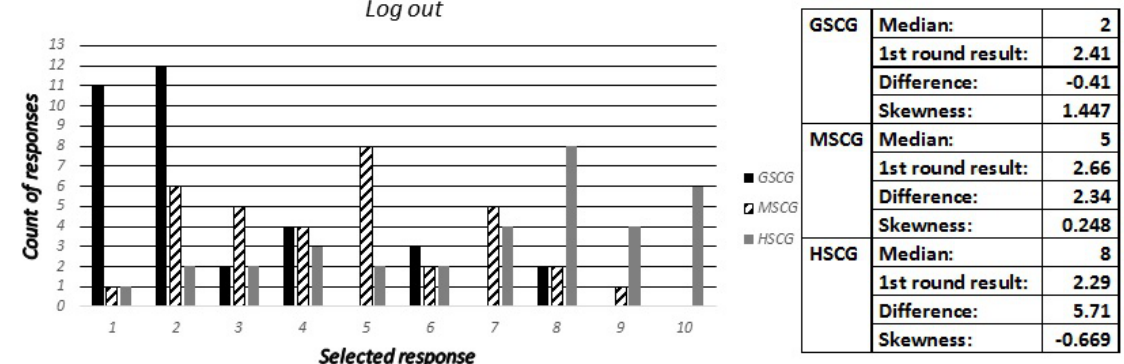
Figure 12. Expert predictions for question 9, “Log out”.